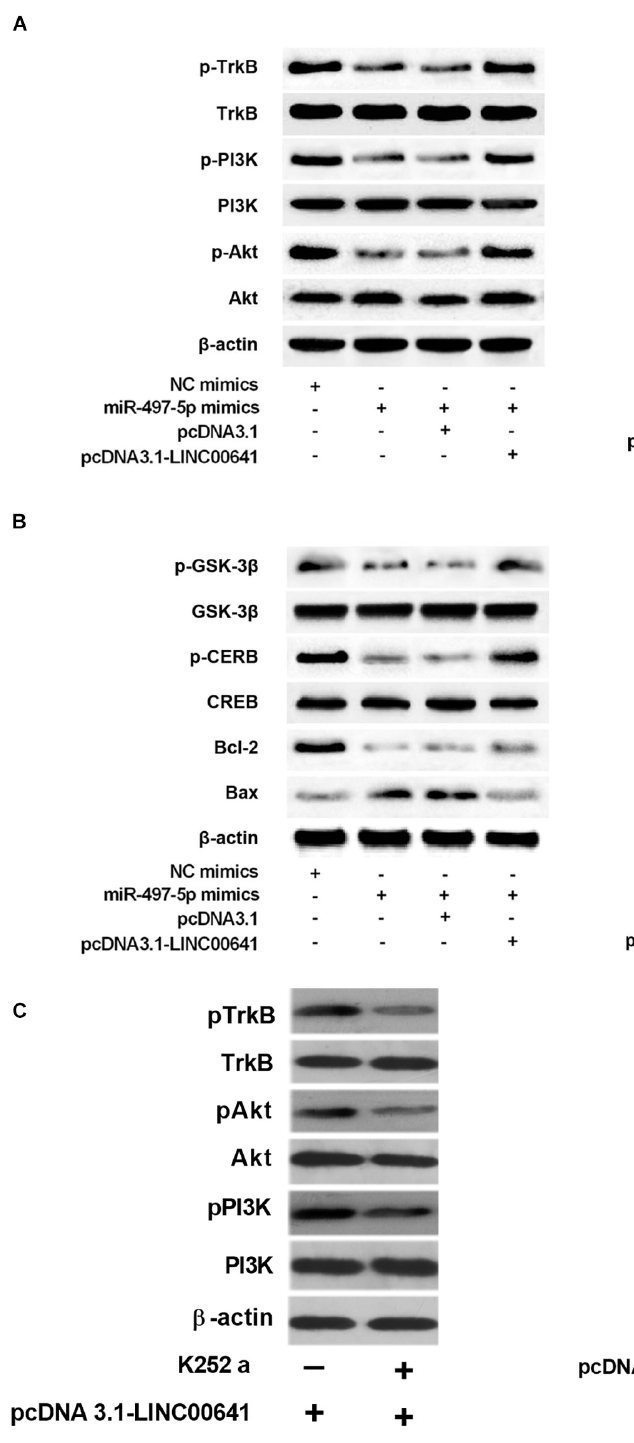
Frontiers in Molecular Neuroscience |